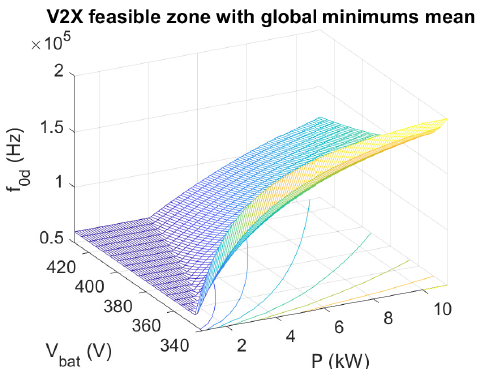
Figure 16. Feedforward frequency in G2V mode based on the optimized values.